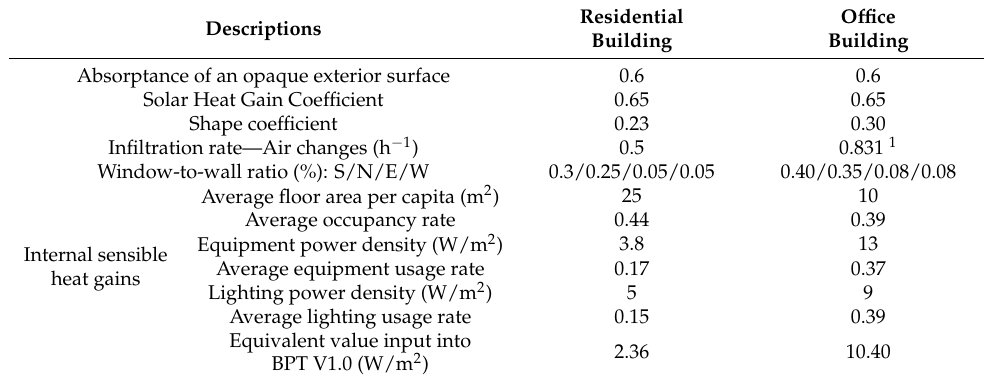
Figure 7. Simulated buildings models and typical floor plans ( a ) residential building; ( b ) office building. Table 8. Simulation assumptions.